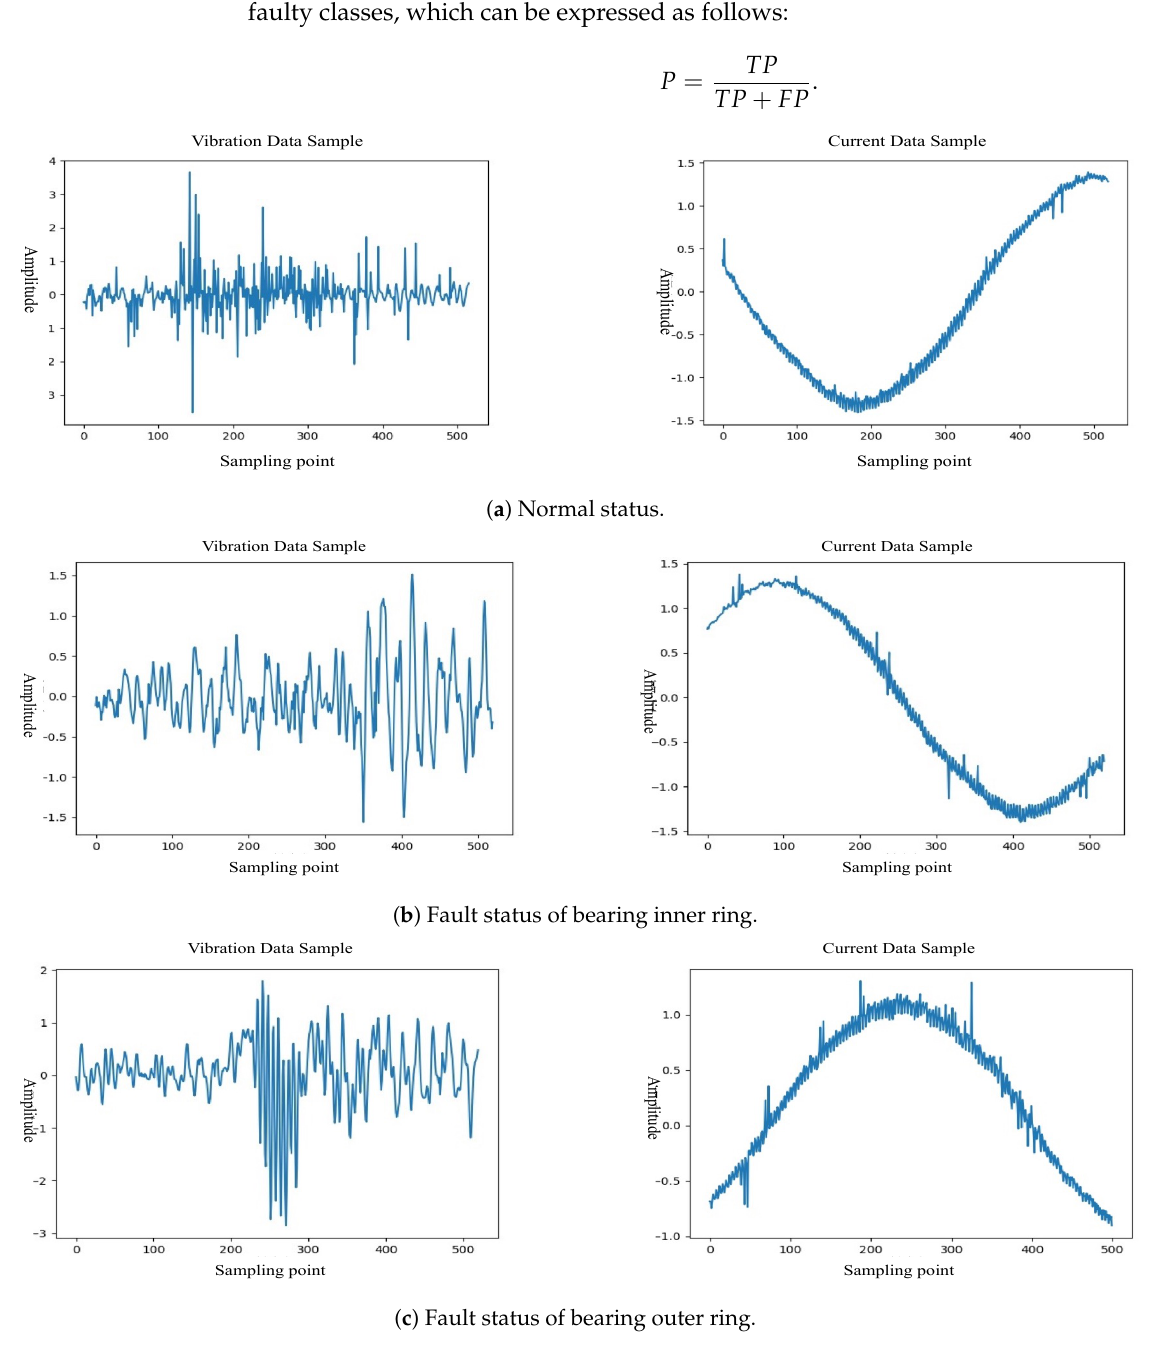
Figure 7. Time-domain waveform diagram of the signal under different operating conditions of the